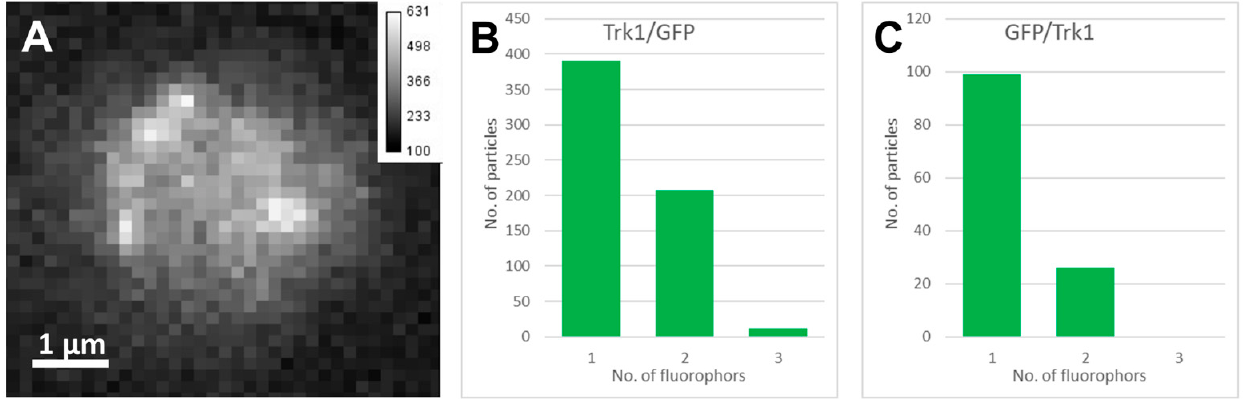
Figure 6. Stepwise photobleaching of Trk-GFP fusion proteins analysed by single molecule fluorescence microscopy (SMFM). ( A ) Fluorescent image of a Trk1/GFP cell. The scale bar gives the fluorescence intensity of particles (a.u., t ill = 10 ms, P = 3.2 kW/cm 2 , average single-molecule signal intensity = 234.7 ± 47 cnts/pix). ( B ) Number of fluorophores in all fluorescent particles analysed in Trk1/GFP cells. ( C ) GFP/Trk1. In Supplementary Figure S5, a typical stepwise photobleaching trace of Trk1/GFP inside the cell is shown.